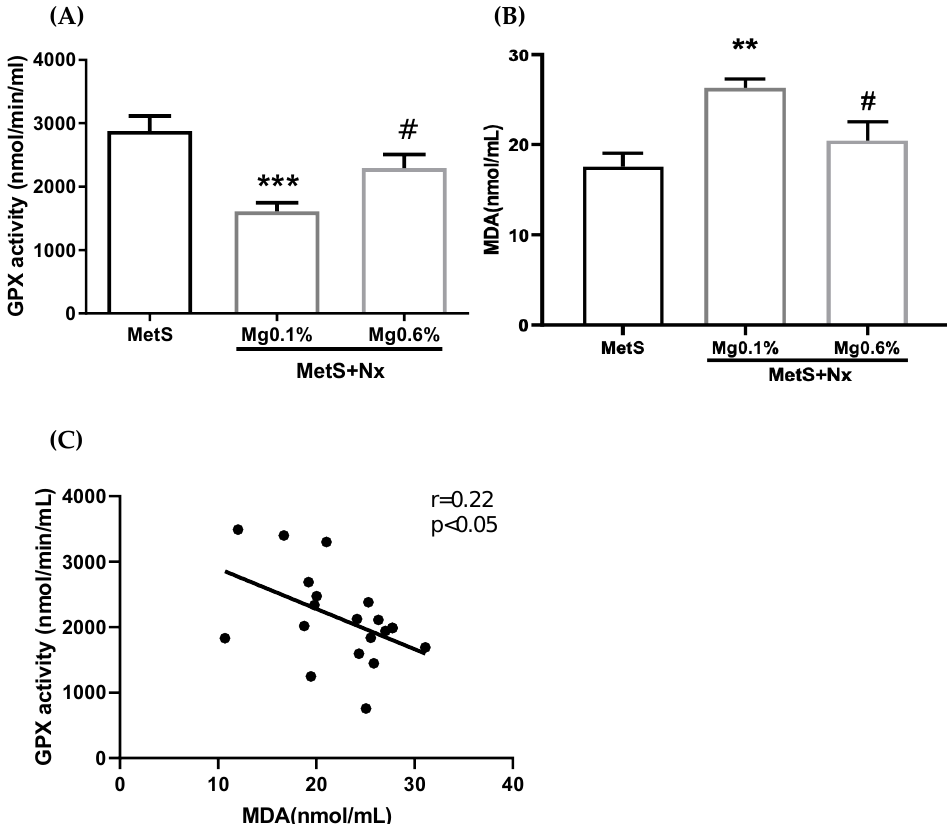
Figure 3. Dietary Mg supplementation reduced plasmatic oxidative stress markers in rats with metabolic syndrome and 5/6 nephrectomy. Nx rats were fed a normal (0.1%) Mg diet or received a dietary Mg supplementation (0.6%). Sham-operated rats fed a normal P and Mg diet served as controls. ( A ) Plasma GPx activity was spectrophotometrically evaluated. ( B ) Lipid peroxidation (MDA) was measured in plasma from the different experimental groups. ( C ) A negative correlation between GPx activity and MDA levels was observed. *** p < 0.001 and ** p < 0.01 vs. MetS; # p < 0.05 vs.